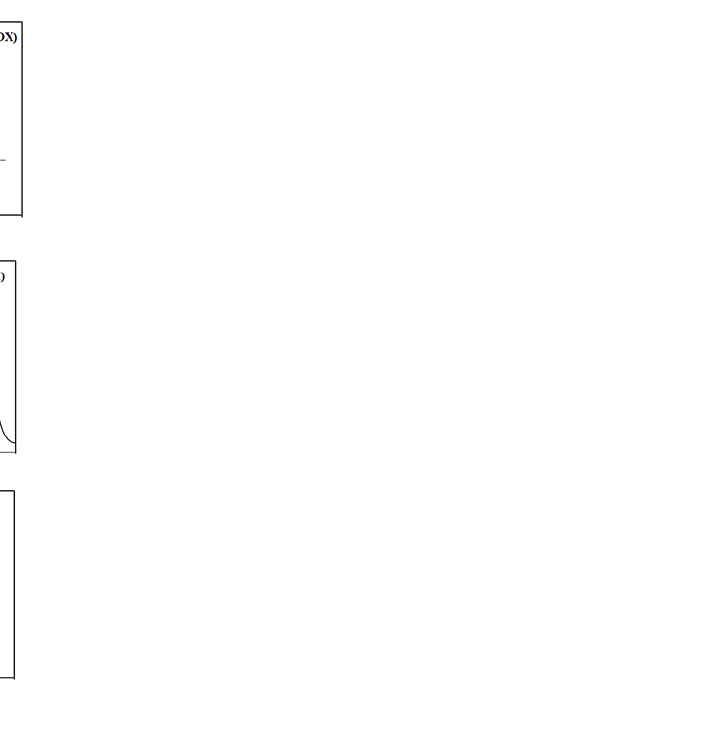
Figure 7. Dose–response curves for free ANTR drugs and APO-encapsulated ANTR nanodrugs, obtained for MDA-MB-231 breast cancer